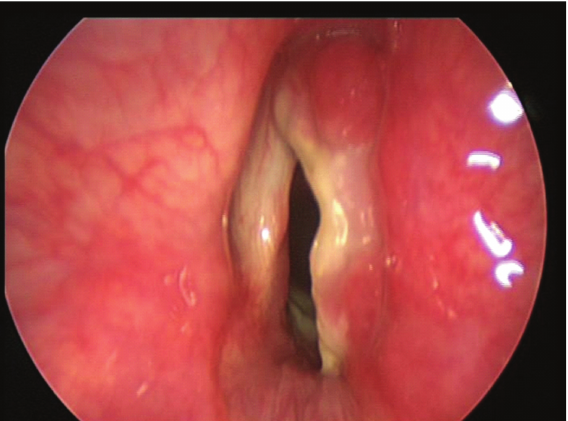
Figure 3: Endoscopic view of larynx 14 days after treatment with evidence of good